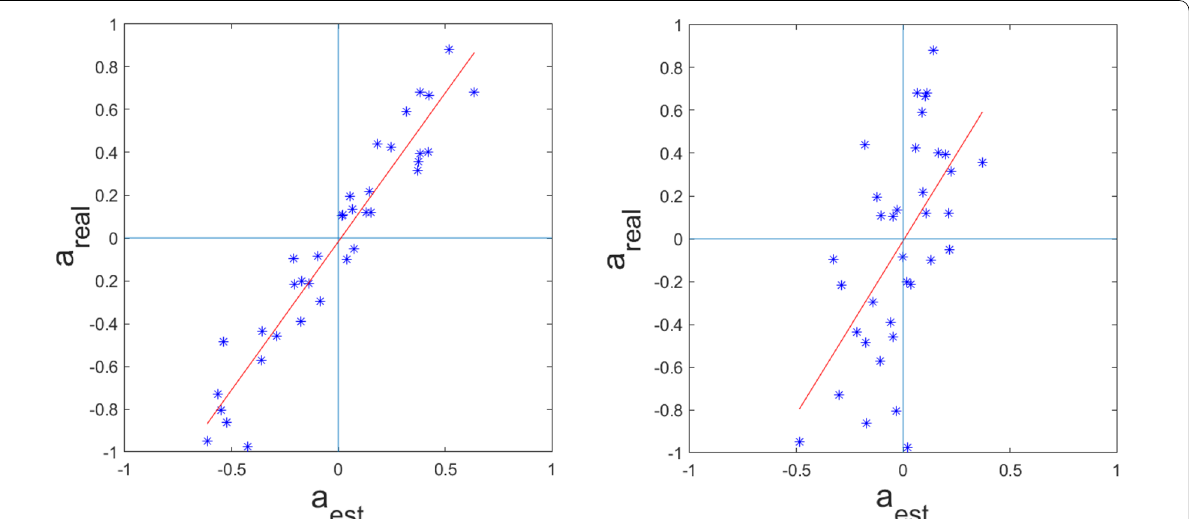
Fig. 3 Scatter plots that relate PF estimates ( x axis) and true values ( y axis) of the autoregressive model for a 6-node network with 100 time samples, in the absence of noise (left) and with SNR = 6dB (right). The lines are the results of a linear fit of the data: in the noiseless case the slope m and the offset q were 1.39 and − 1.62 · 10 − 2 , respectively; in the noisy case, m = 1.62 and q = 8 · 10 −